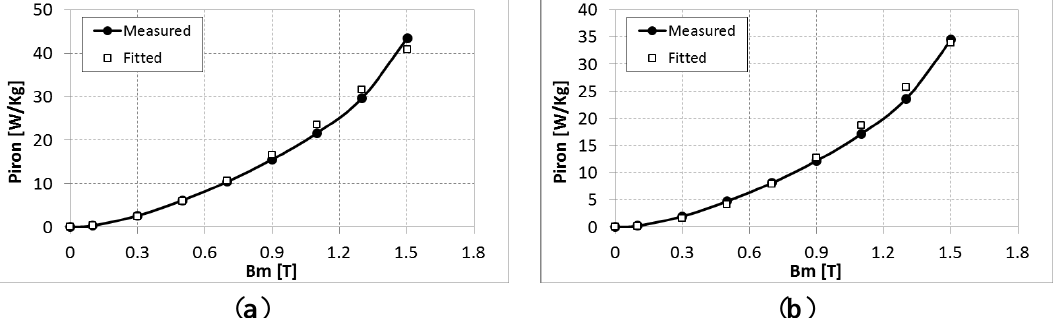
Figure 3. Iron losses at 400 Hz for ( a ) rolling and ( b ) transverse